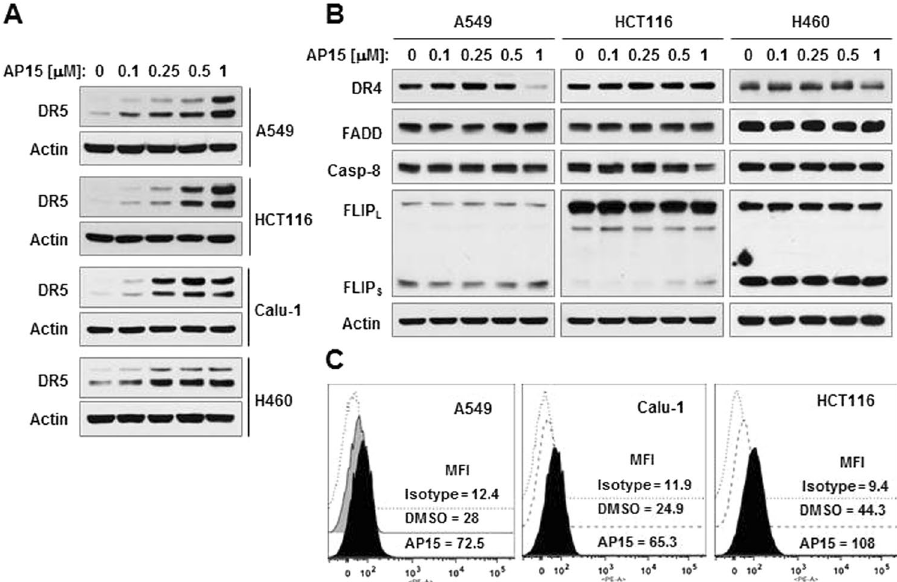
Figure 1. b-AP15 primarily increases the levels of DR5 ( A and C ), but not other DISC components ( B ), in cancer cells. ( A and B ) The indicated cancer cell lines were exposed to varied concentrations of b-AP15 as shown for 9 h and then harvested for preparation of whole-cell protein lysates and subsequent Western blotting. Full-length blots/gels are presented in Supplementary Figure S1. ( C ) The given cell lines were treated with 0.5 μ M b-AP15 for 8 h and then harvested for staining of DRs followed by flow cytometric analysis of cell surface DR5. The dashed-line open peaks represent DMSO-treated cells stained with a matched control PE- conjugated IgG isotype antibody. The filled gray or dotted-line open peaks are DMSO-treated cells stained with PE-conjugated anti-DR5 antibody. The filled black peaks show b-AP15 treated cells stained with PE-conjugated anti-DR5 antibody. MFI for each sample was